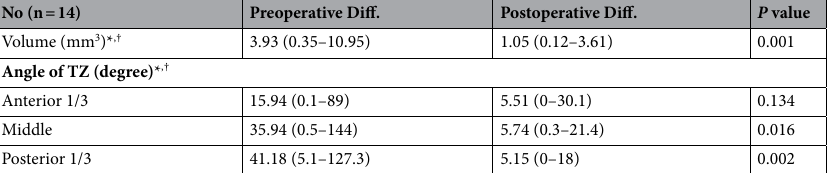
No (n = 14) Preoperative Diff. Postoperative